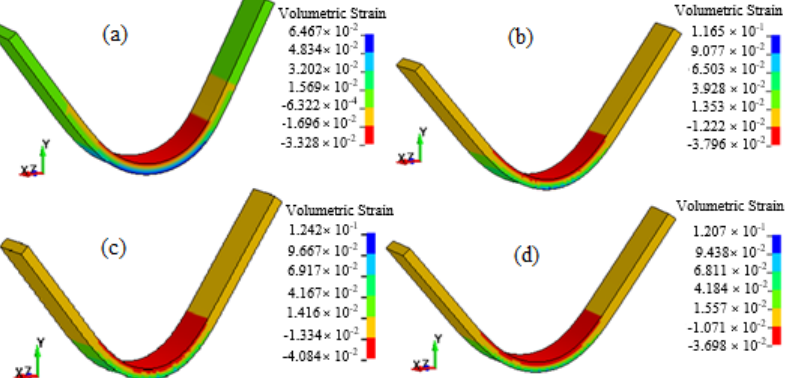
Figure 8. Contour plots of long-beam configuration for volumetric strain at different loading rates ( a ) 0.05 mm/s, ( b ) 0.5 mm/s, ( c ) 5 mm/s, and ( d ) 10 mm/s.